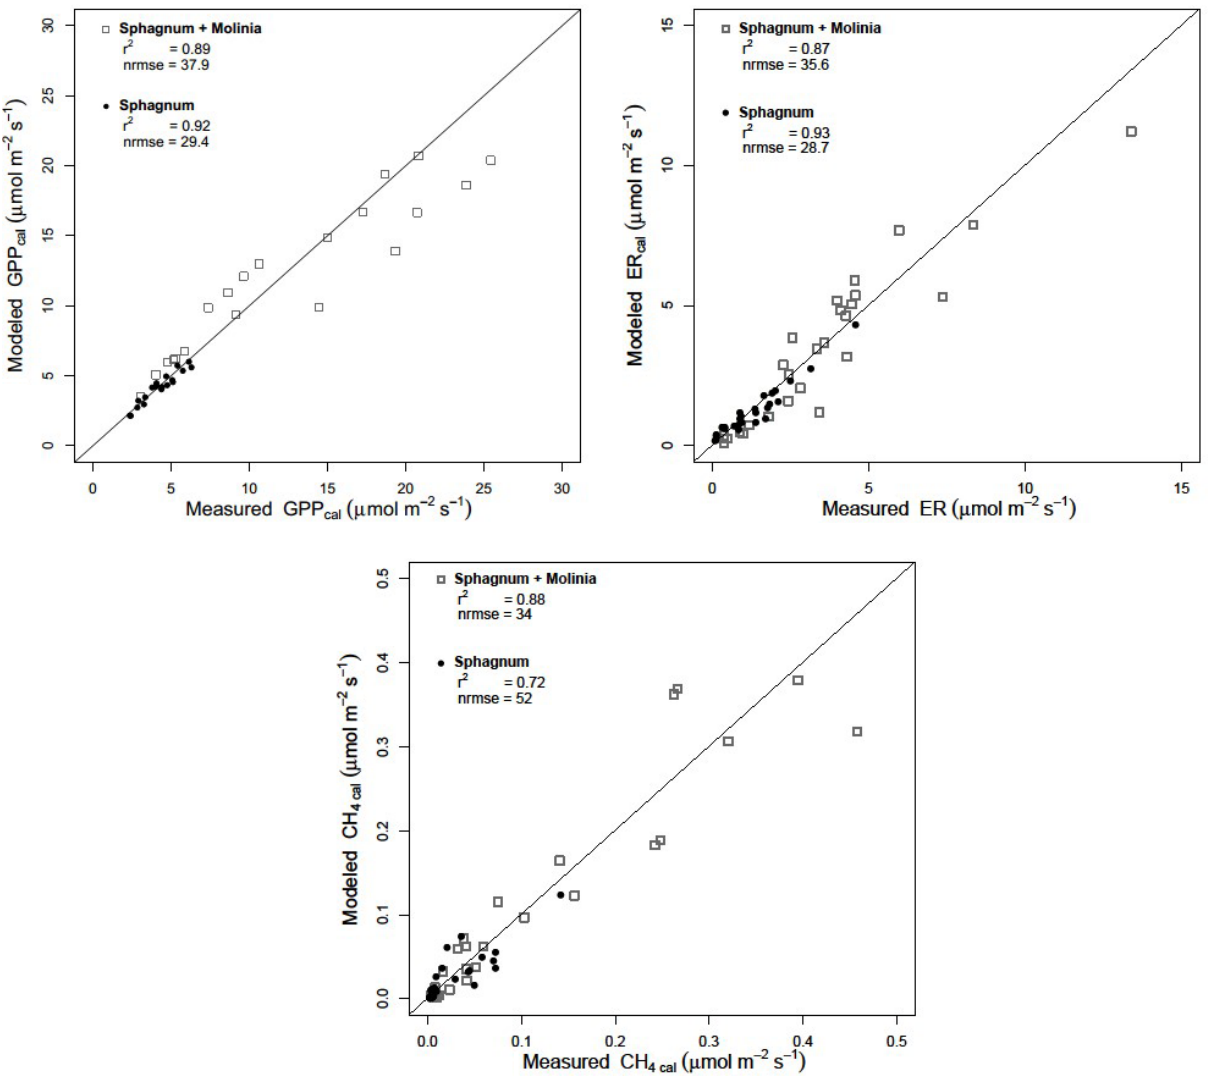
Figure 3. Calibration of the models by comparison of simulated and measured ecosystem respiration (ER), gross primary production (GPP) and CH 4 emission (CH 4 ) in Sphagnum and Sphagnum + Molinia plots. The diagonal lines represent the 1 : 1 correlation.